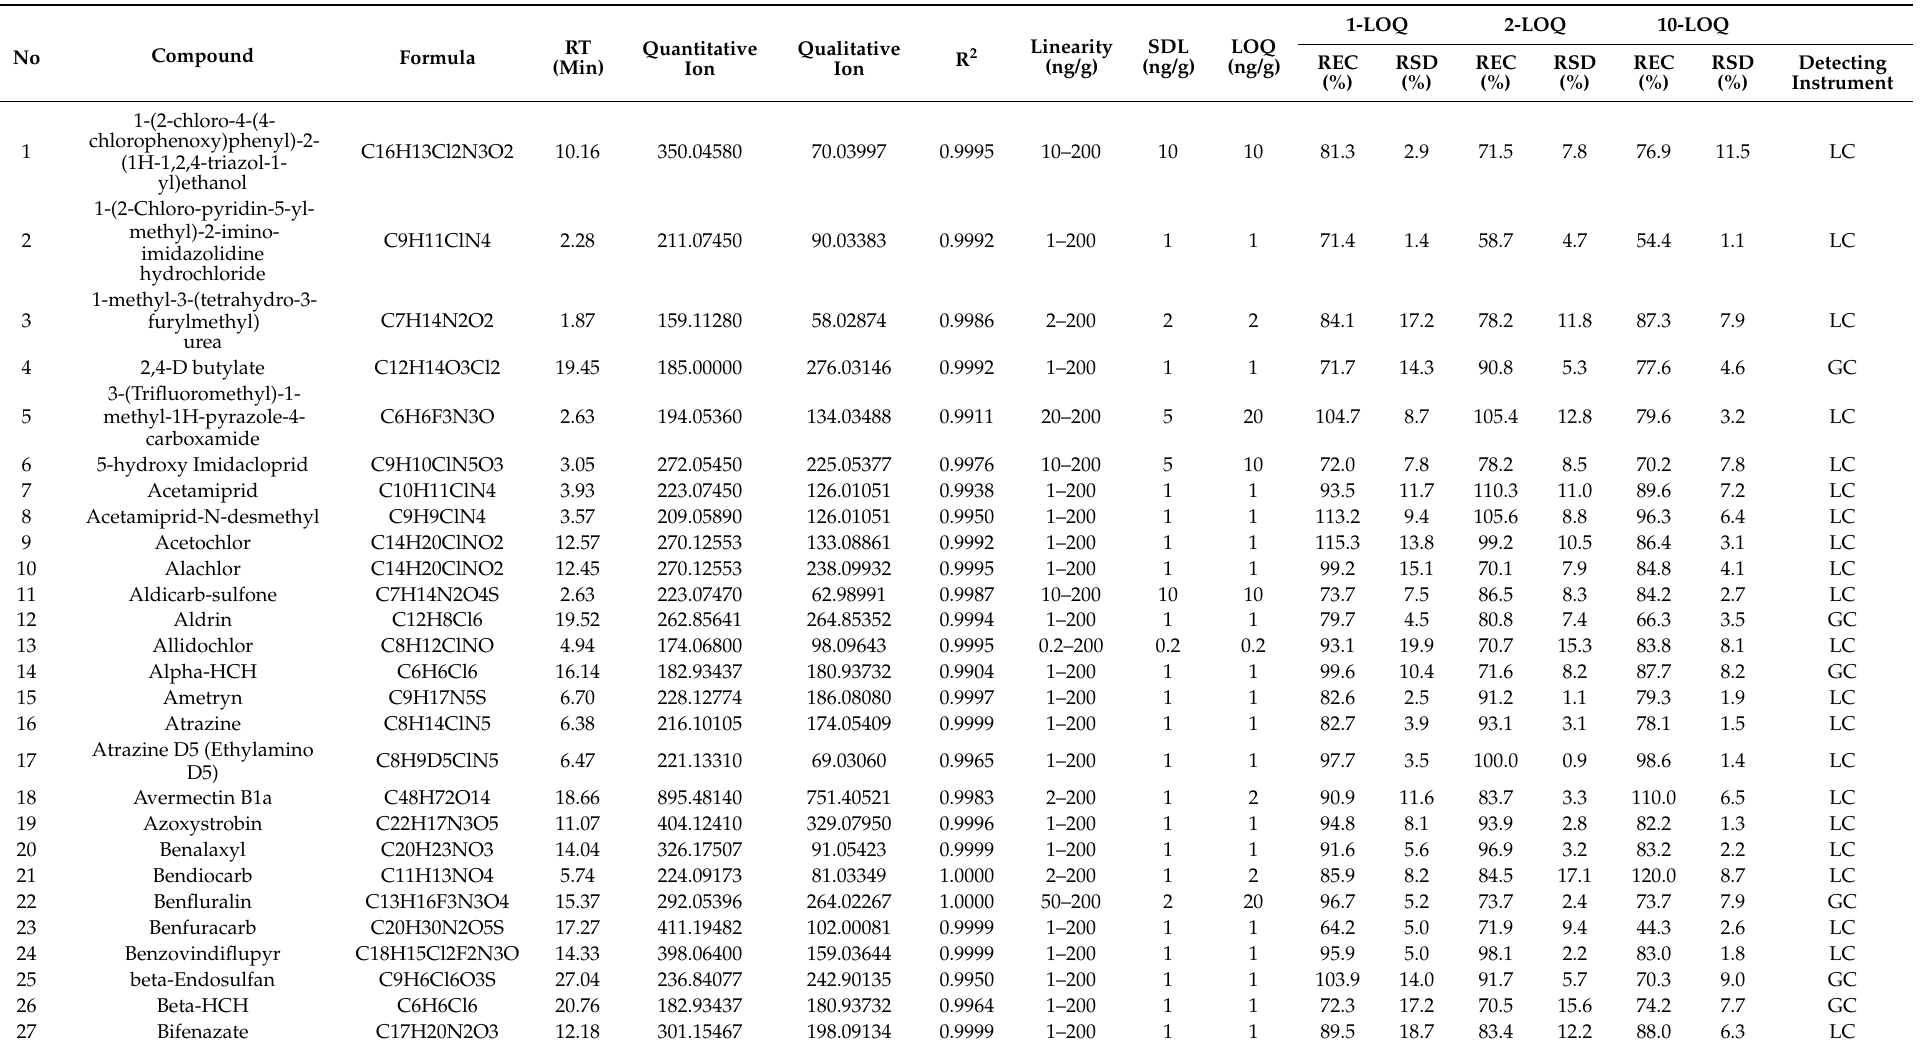
Table 1. Compound information, screening detection limits (SDLs), limit of quantification (LOQ), linear range, R 2 , recovery, and RSD of 237 pesticides (n =